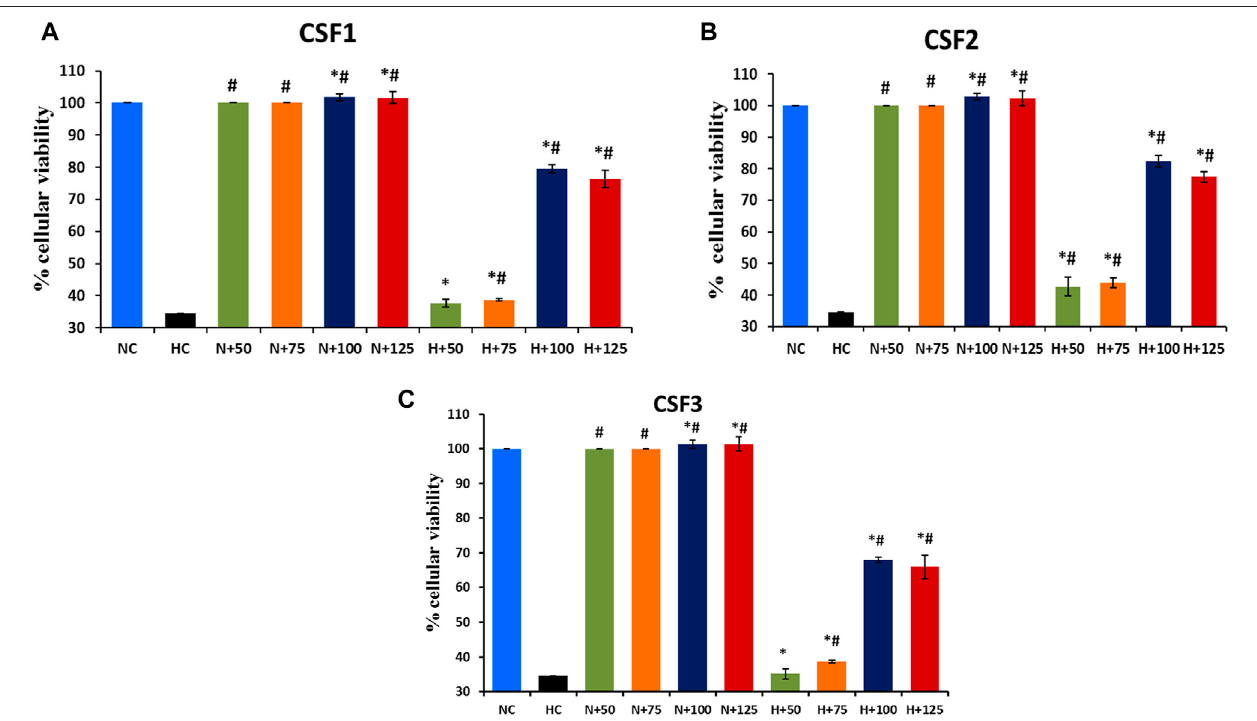
FIGURE 9| Restoration ofcellular viability by C. sinensis supercritical CO 2 extracts. At an optimum dose of100 µg/ml, CSF1, CSF2 and CSF3 improved HEK 293 cellular viability to 79.53% (A) , 82.36% (B) and 68% (C) , under hypoxia. N, normoxia; H, hypoxia; N+x, supplementation of various doses (x (cid:1) 50/75/100/125 µg/ml) of CSF in normoxia; H+x, supplementation of various doses (x (cid:1) 50/75/100/125 µg/ml) of CSF in hypoxia. Results are expressed as mean ± SD ( n (cid:1) 3). * represents signi fi cant change at level of p < 0.05 with respect to N, # represents signi fi cant change at level of p < 0.05 with respect to